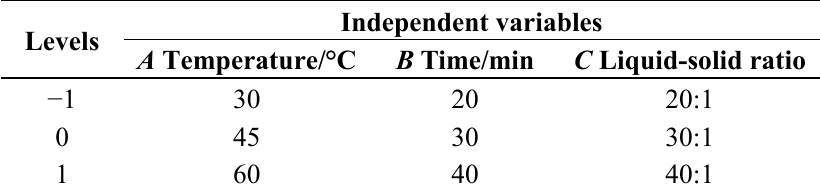
Table 3. Factors and levels of response surface analysis.